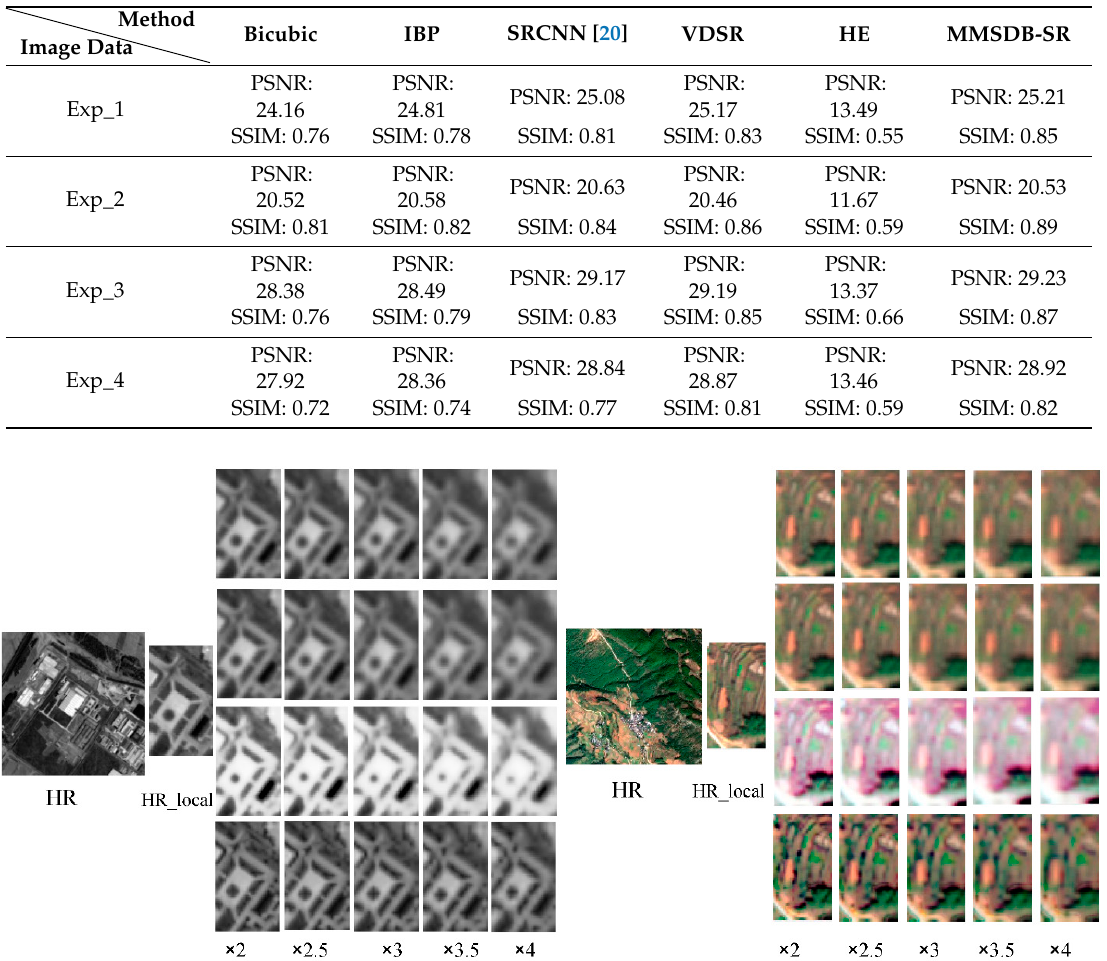
Table 3. The objective evaluation index results with random Noise with the range of [ − 5,5]. DataMethod Image